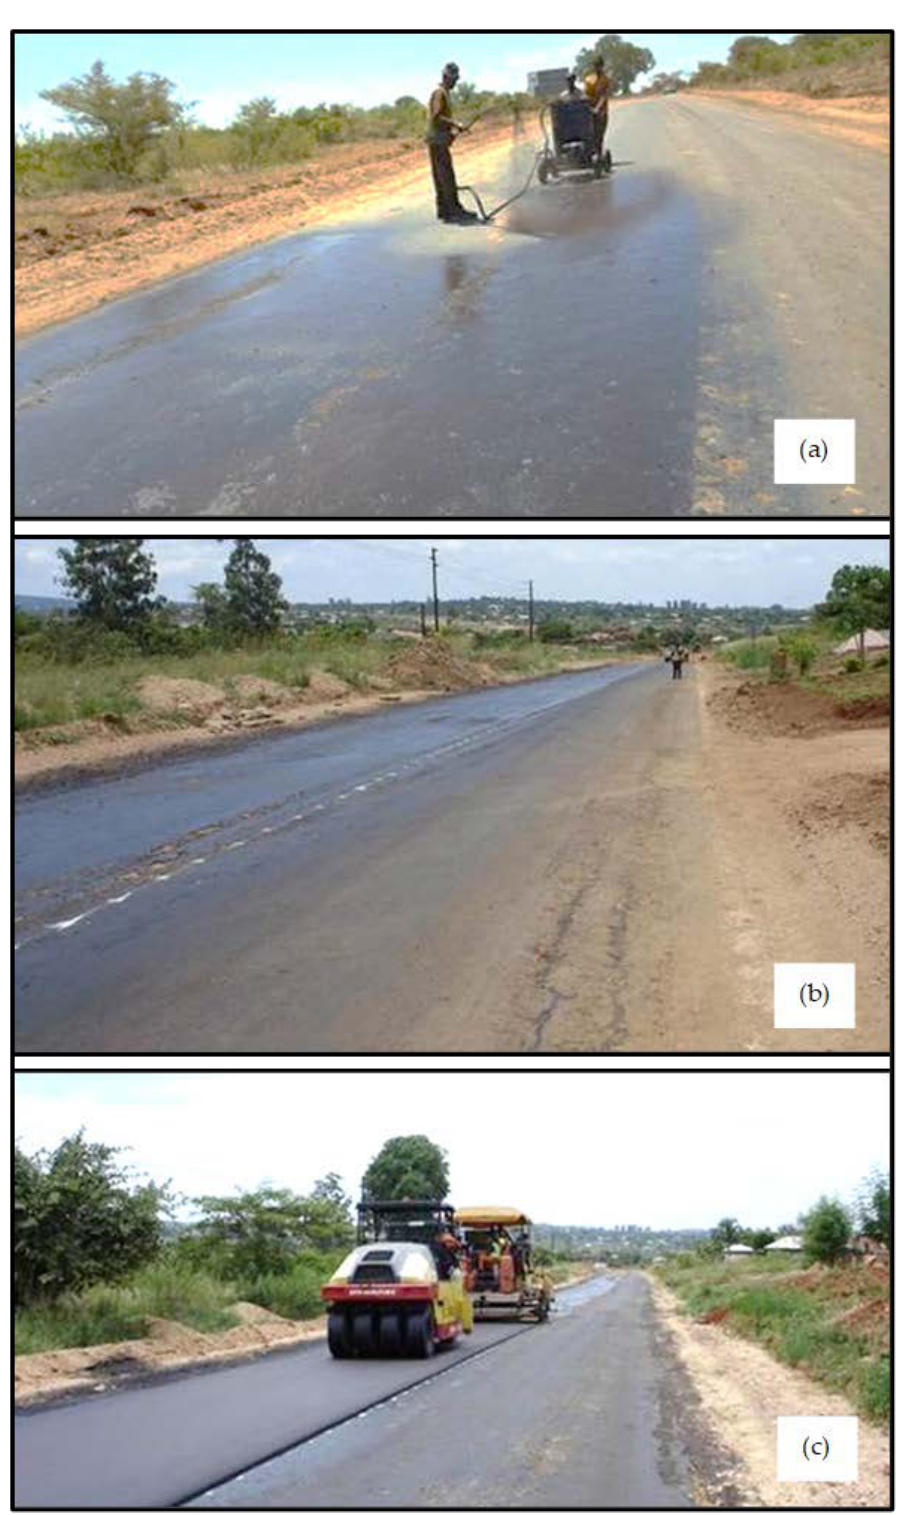
Figure 13. ( a ) Hand application of a quick-drying anionic-diluted NME prime coat to protect the base before application of the surfacing; ( b ) application of a tack coat 2 months after construction of the base-layer (opened to traffic); and ( c ) application of the surfacing. Note the little damage to the base-layer after two moths open to traffic during the holiday and rainy season.